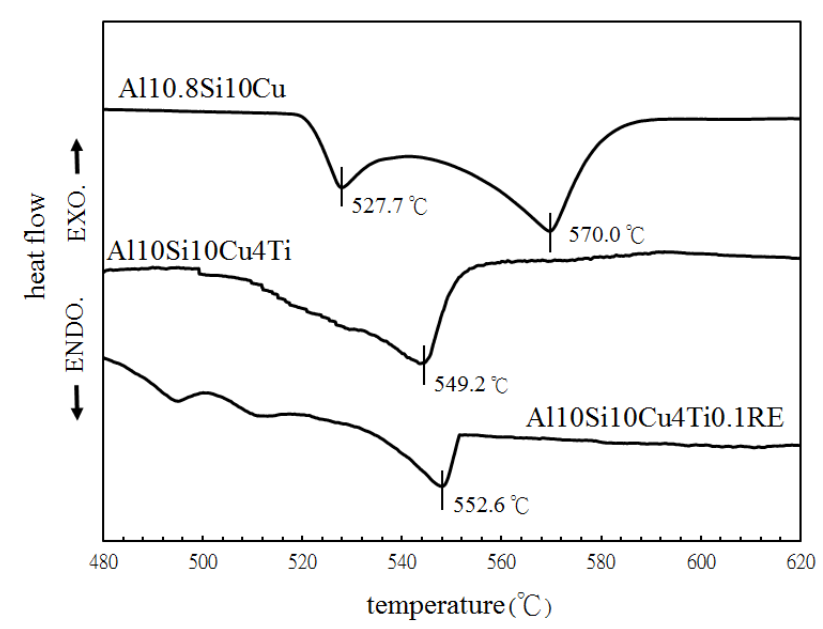
Figure 4. DTA curves of the Al10.8Si10Cu, Al10Si10Cu4Ti and Al10Si10Cu4Ti0.1RE filler alloys. Figure 5a–c respectively present the microstructures under BSE mode of the AA6061 joints with Al10.8Si10Cu, Al10Si10Cu4Ti and Al10Si10Cu4Ti0.1RE filler alloys after brazing at 530 ◦ C for 10 min. Some Si-rich phase particles and a large number of Al 2 Cu precipitates were found at grain boundaries in the Al10.8Si10Cu filler alloy. The Al 2 Cu particles were smaller in the titanium-containing Al10Si10Cu4Ti and Al10Si10Cu4Ti0.1RE filler alloys than in the Al10.8Si10Cu filler alloy. Only a very few tiny AlLa intermetallic compound particles with a size of 2–10 µ m have been found in the Al10Si10Cu4Ti0.1RE filler alloy [27,28]. The addition amount of mixed rare-earth elements is very small, only 0.1 wt.%. Thus, except for the AlLa phase, another trace rare-earth element phase cannot be observed by SEM. In the study of Chen et al. [28], the slender grains of the AlLa intermetallic compounds with a size of about 5–15 µ m can be found in the A356 aluminum alloy with 0.3% La and 0.2% Yb mixed rare-earth elements. Moreover, Samuel et al. [27] studied the metallography of rare-earth intermetallic compounds in the rare-earth element-containing Al-Cu-Mg and Al-Si-Cu-Mg alloys. The strip grains of aluminum-rare-earth intermetallic compounds with a size of 15–20 µ m can be determined by SEM and EDX. According to the composition analysis of EDX and the studies of rare-earth elements containing aluminum alloys by Chen et al. [28] and Samuel et al. [27], it is believed that there are AlLa intermetallic compounds in the Al10Si10Cu4Ti0.1RE filler alloy.